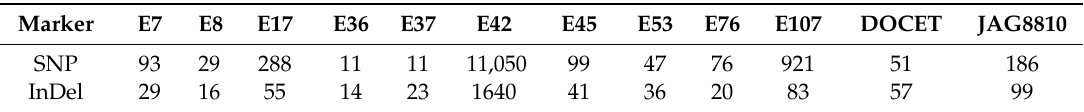
Table 2. Number of private SNPs and InDels reported for each genotype analyzed on the whole dataset of 26,113 filtered markers.